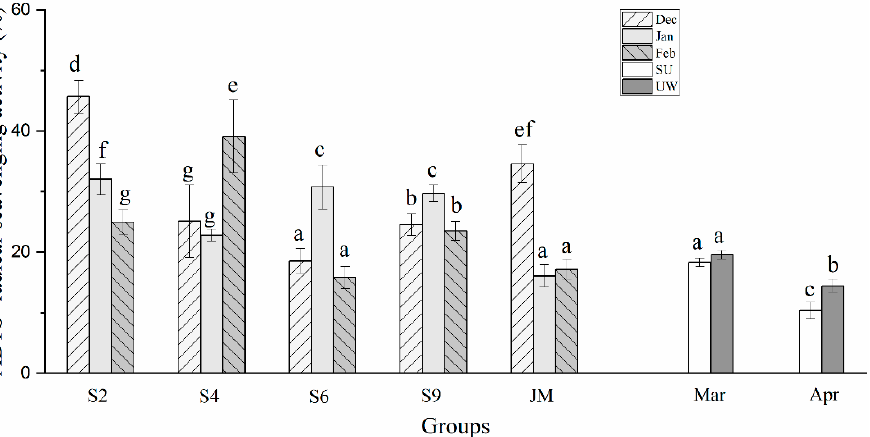
Figure 5. ABTS + radical-scavenging activity changes in N. yezoensis collected from different cultiva- tion sites and periods. Data represent the mean ± SD ( n = 3). Different letters indicate a significant difference ( p < 0.05).